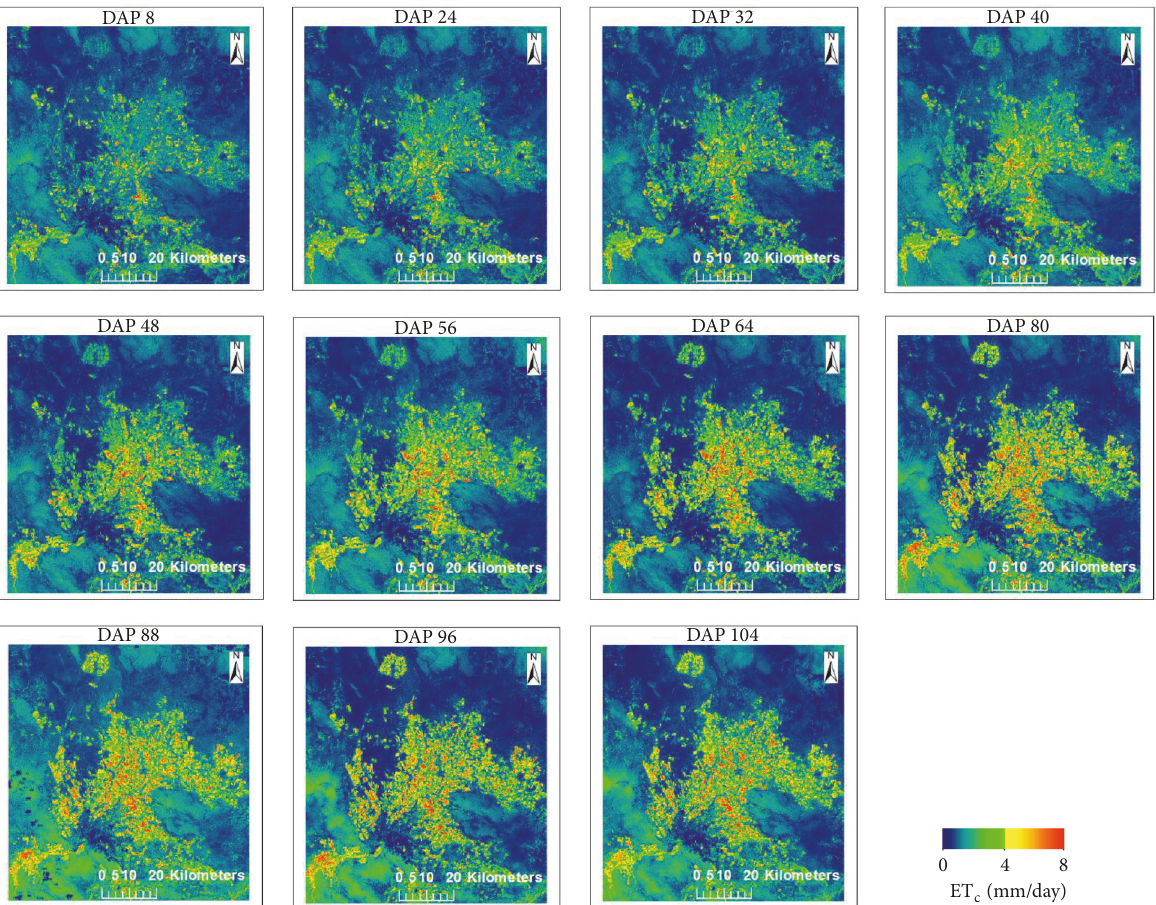
Figure9:SpatialandtemporalET mapsgeneratedwithERDASImagineSoftware(ModelMaker)andArcGISversion10.3.1for2014growing c season in northern